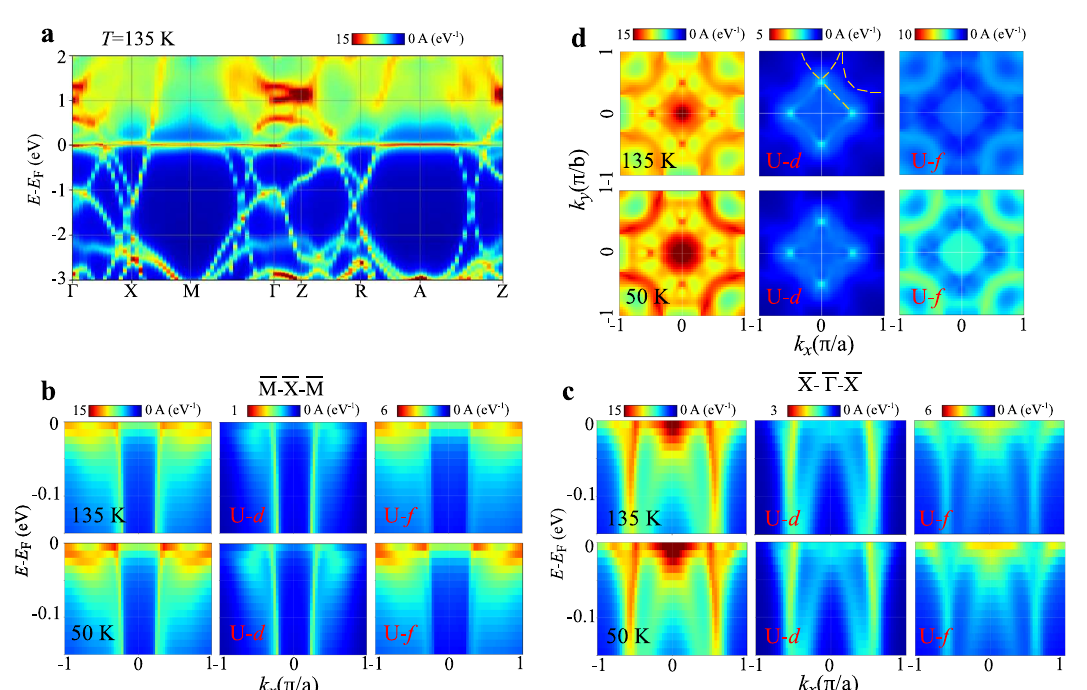
Fig. 4 | Calculated electronic structure of USbTe. a Calculated spectral function at 135K. b , c Momentum-resolved spectral function along the b M (cid:2) X (cid:2) M and c X (cid:2) Γ (cid:2) X at 135and 50K.U-6 d (U-5 f ) projected spectral functionisshown inthe